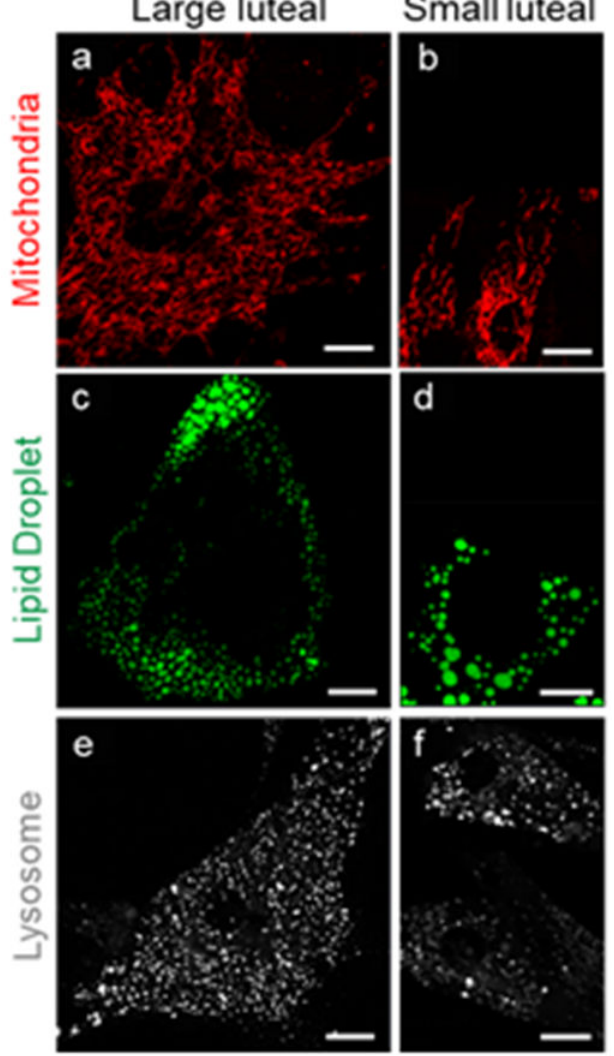
Figure 1. Organelle differences between steroidogenic large and small bovine luteal cells. Confo- cal microscopy was employed to visualize intracellular organelles in cultured bovine luteal cells. Representative micrograms of mitochondria (( a , b ) MitoTracker); lipid droplets (( c , d ) TopFluor Choles- terol);and lysosomes (( e , f ) LysoTracker) in large and small luteal cells (left to right). Micron bar represents 10 µ